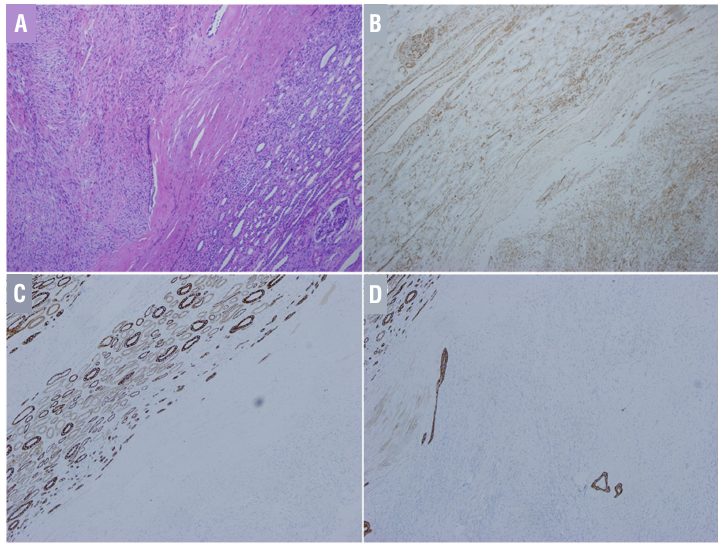
figure 3 - Postoperative pathological examination verified metanephric adenofibroma (×100). (A) spindle cells proliferate and the cell size is consistent with a few acini and tubular structures scattering among them and some are cystic expansion. The lined epithelial cells did not show atypia. Immunohistochemical results show that vimentin is positive for tumor (B) and ck is positive for small tube and negative for tumor (c,